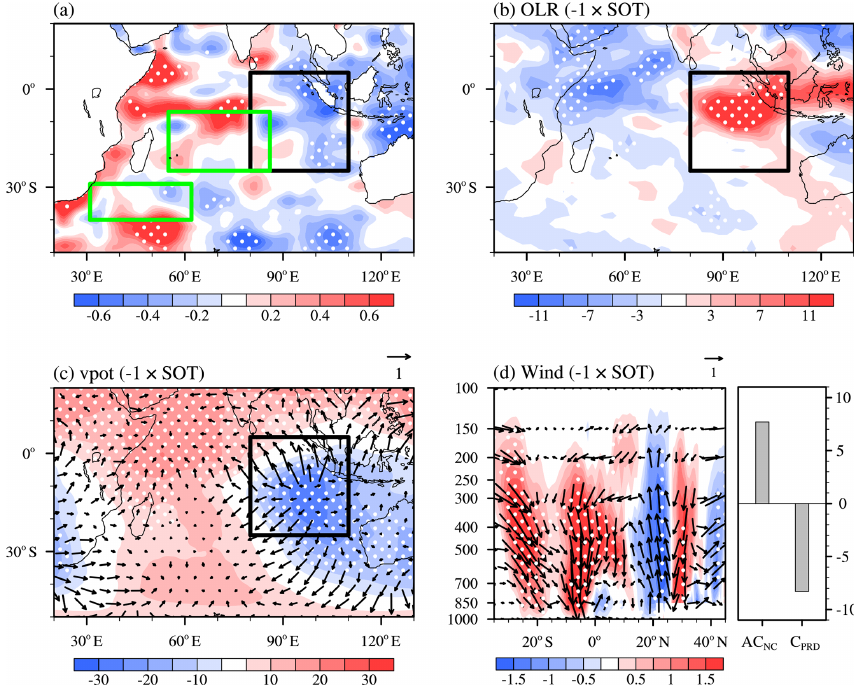
Figure 8. (a) Composites of mean 0–60m subsurface ocean temperature (unit: K) in summer associated with the SIOD (positive SIOD years minus negative SIOD years) from 1980 to 2019. The green boxes represent the centers of the SIOD, and the black box indicates where the SOT index is calculated. Composites of (b) OLR (unit: Wm − 2 ) and (c) velocity potential (unit: 10 5 m 2 s − 1 , shadings) and divergent winds (unit: ms − 1 , vectors) at 10m in summer associated with SOT indexes of opposite sign (negative SOT years minus positive SOT years). The black box represents the center of the SOT. (d) Composites of summer-mean winds (unit: ms − 1 , arrows) and omega (unit: 10 − 2 Pas − 1 , shadings) over 90–120 ◦ E, and the anomalies of AC NC and C PRD (unit: gpm, bars) associated with SOT indexes of opposite sign. The white dots indicate that the composites with shading were above the 90% confidence